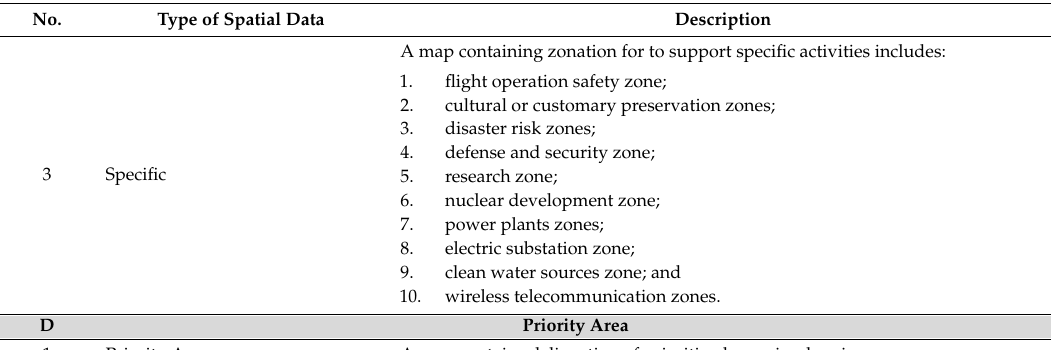
Table A3. List of urban zonation maps produced in the urban planning processes at map scale 1:5000 or better (Ministry of Public Works Regulation, 2011) which are produced by city